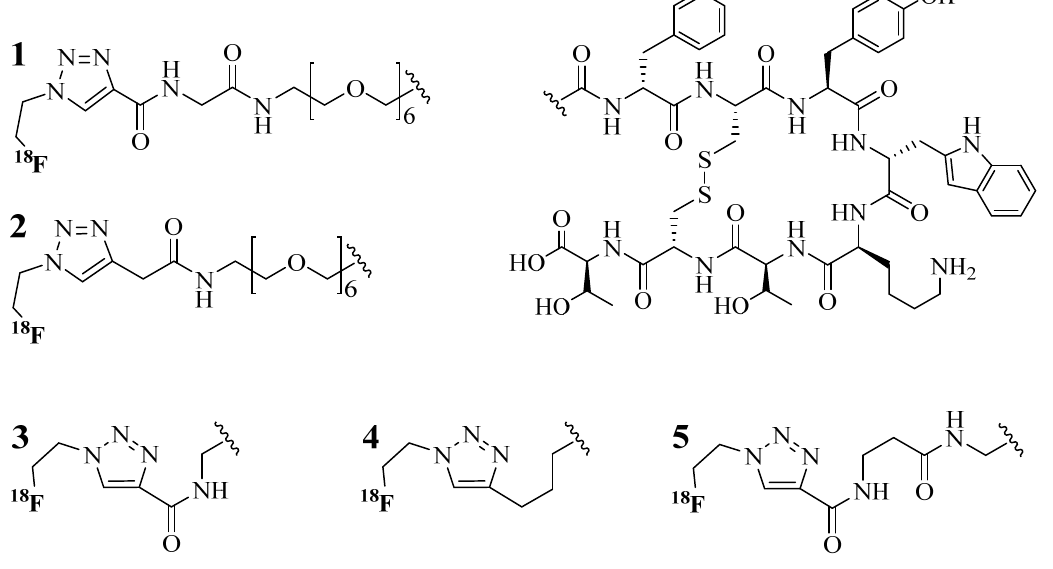
Figure 4. 18 F-labeled TOCA analogs for tumor imaging. CuAAC condition: pH 5 acetate buffer, DMF and acetonitrile (MeCN) (8:3:10) at 25 °C plus; CuSO